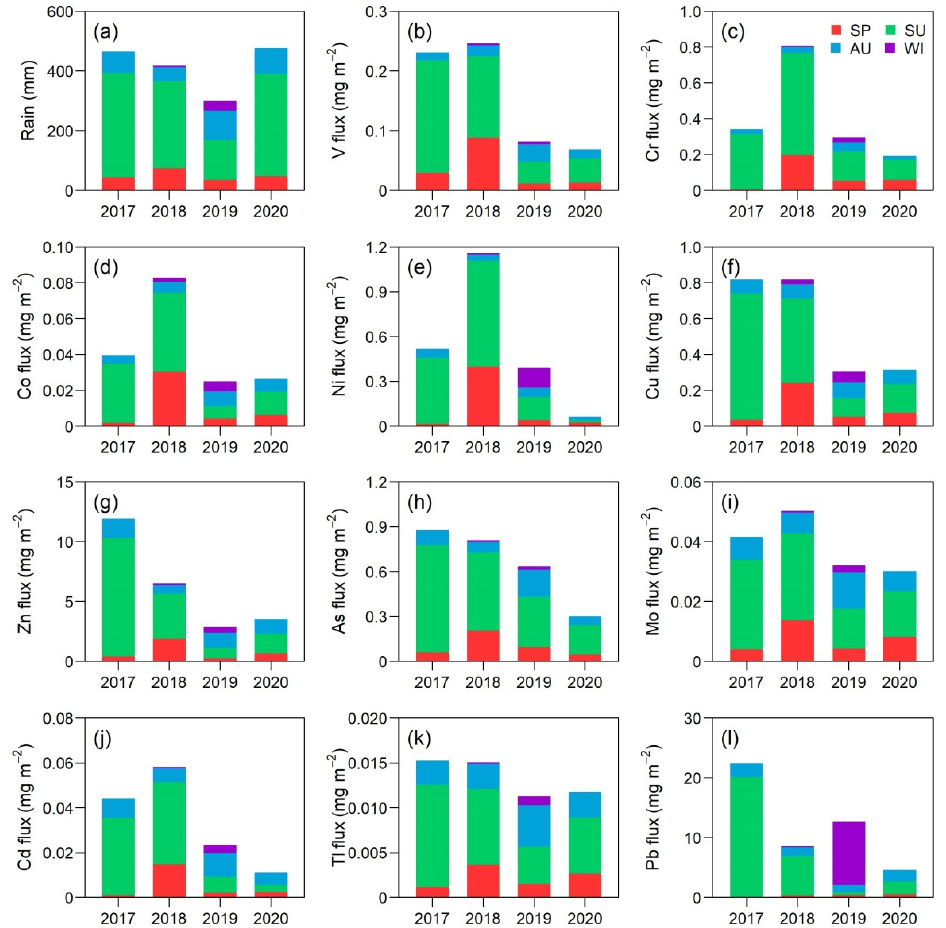
Figure 3. The annual variation of rainfall amount ( a ) and bulk deposition fluxes of MMs (( b ) = V, ( c ) = Cr, ( d ) = Co, ( e ) = Ni, ( f ) = Cu, ( g ) = Zn, ( h ) = As, ( i ) = Mo, ( j ) = Cd, ( k ) = Tl, ( l ) = Pb) observed during 2017–2020 (SP = spring, SU = summer, AU = autumn, WI = winter). The data in autumn and winter 2016 ( n = 2) was not included.